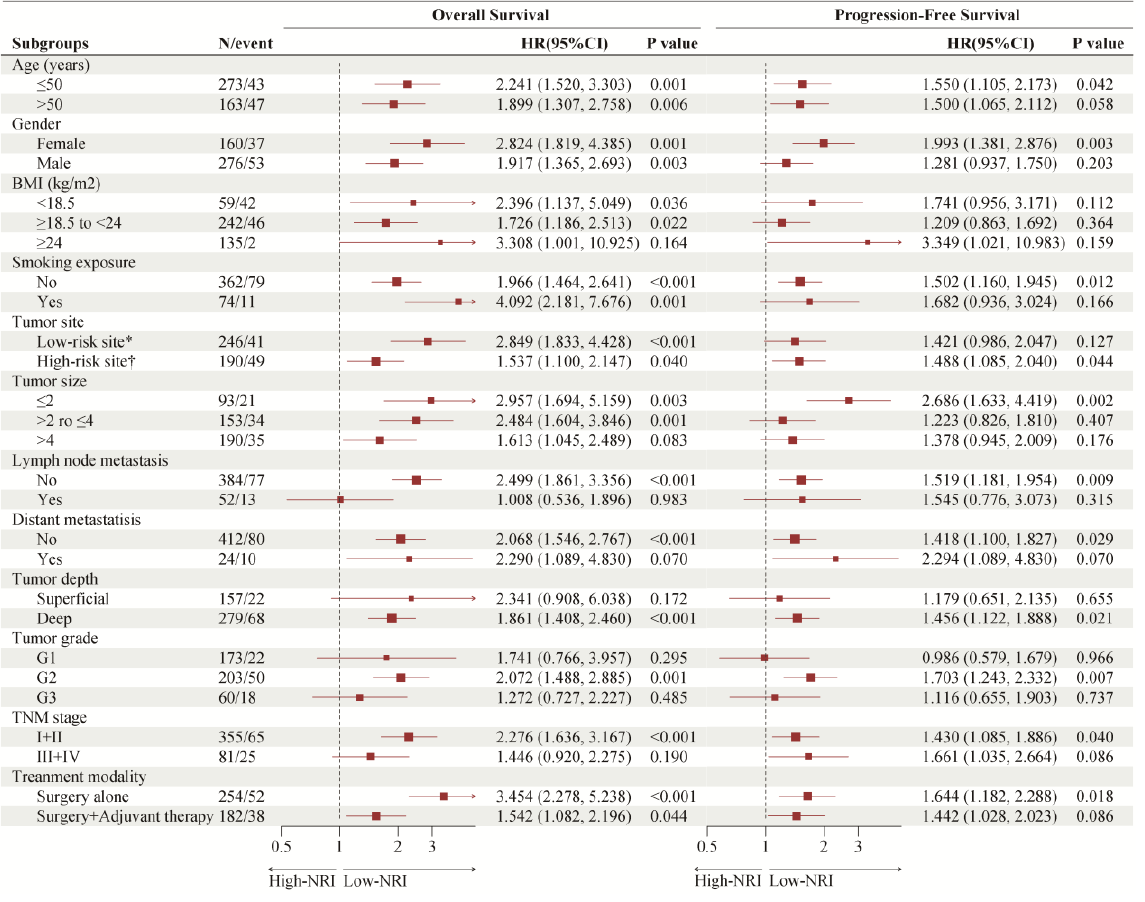
Figure 4. Forest plot of NRI groups on overall survival and progression-free survival in subgroup analyses. NRI: nutritional risk index. * Scalp or face and neck; † Nasal cavity or paranasal sinus, oral cavity, pharynx or larynx, and others.